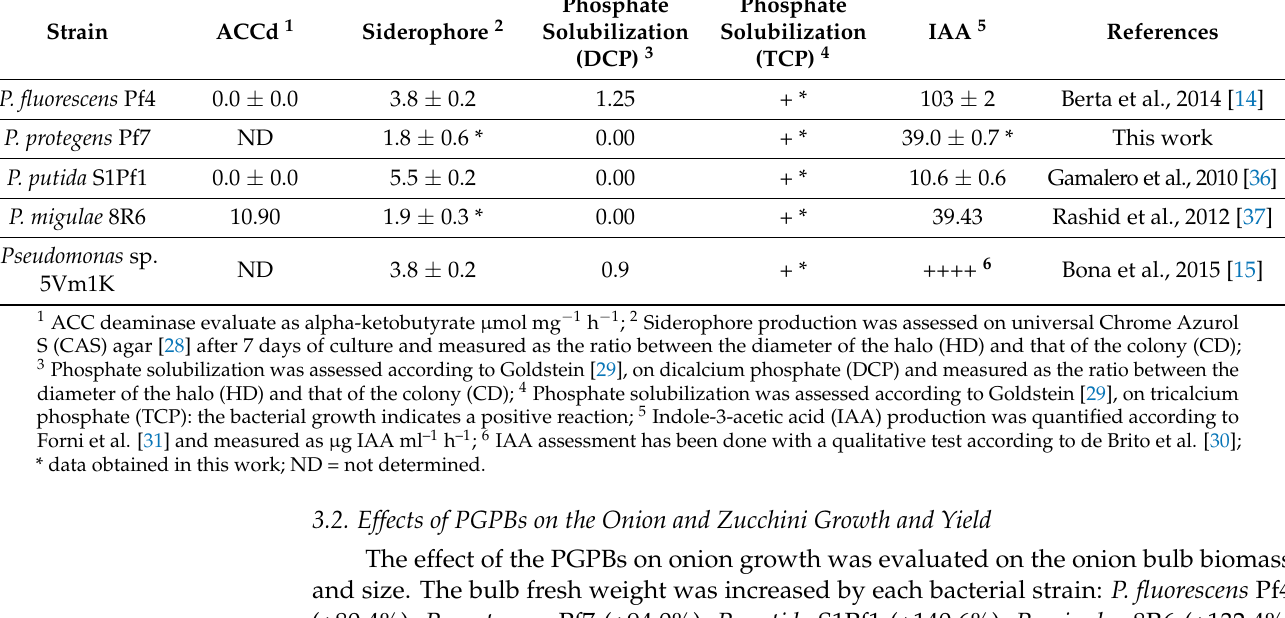
Table 2. Physiological trait characterization of the bacterial strains employed to inoculate onion and zucchini seeds. Strain ACCd 1 Siderophore 2